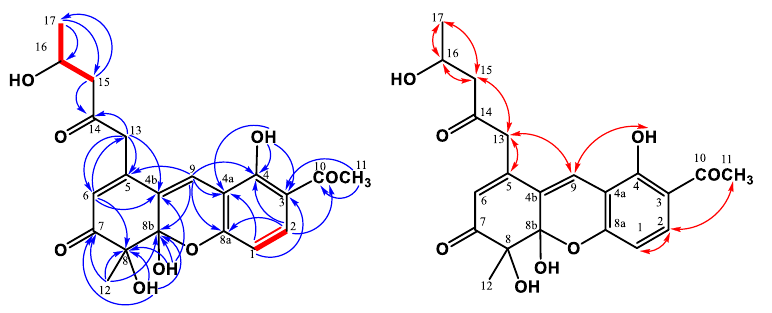
Figure 5. Key 1 H- 1 H COSY ( ━ ), HMBC (H → C), and NOESY (H ↔ H) correlations of 4.